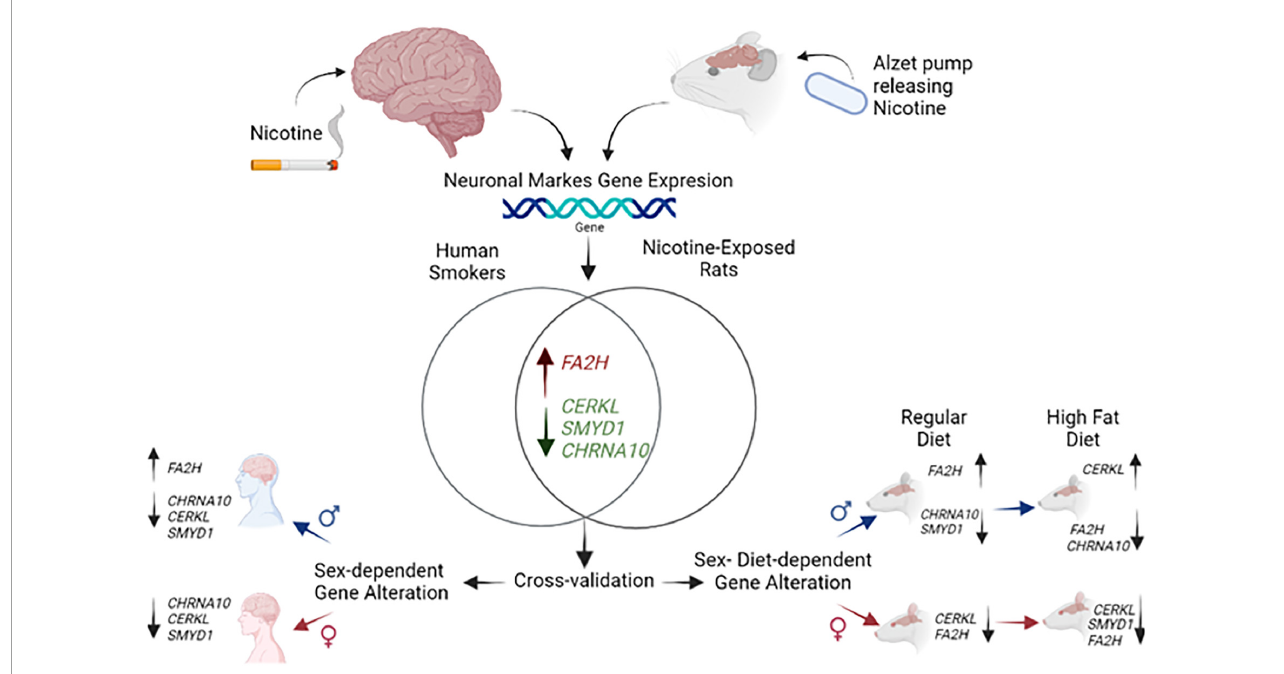
FIGURE5 Model indicating gene dysregulation in nicotine-exposed humans and rats by sex and diet. Gene expression of CHRNA10 , CERKL , SMYD1 , and FA2H exposed to nicotine based on sex and